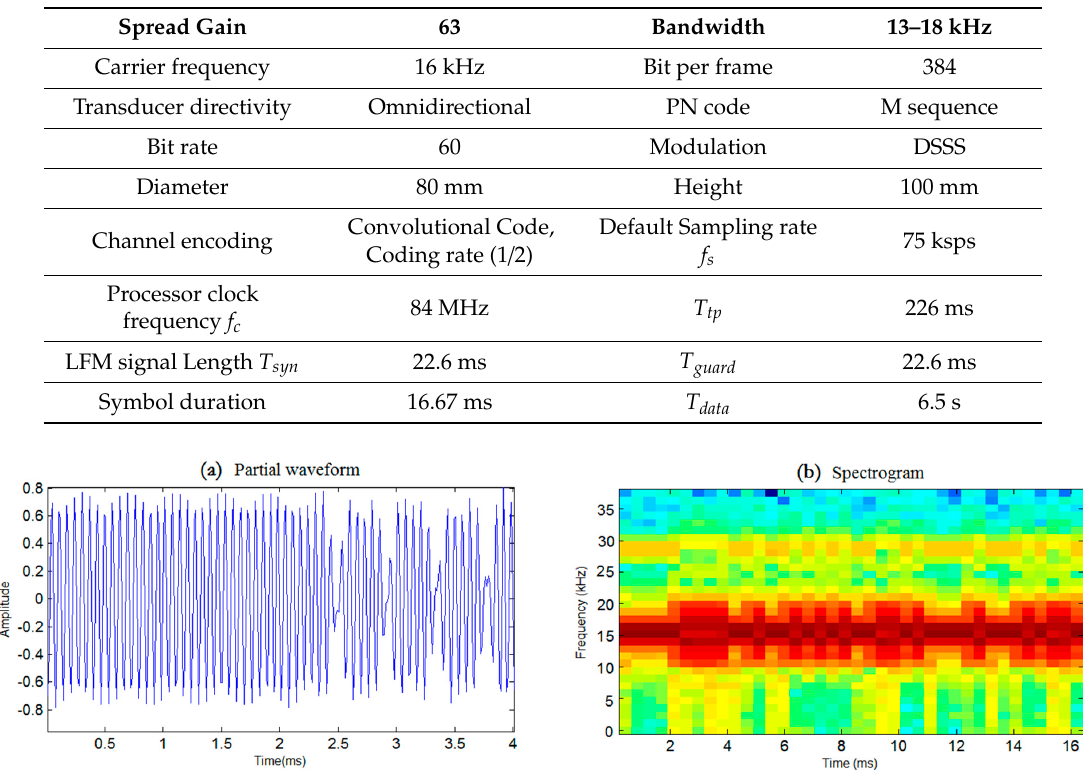
Figure 3. Partial waveform and spectrogram of a data symbol. ( a ) Partial wavform, ( b ) Spectrogram.